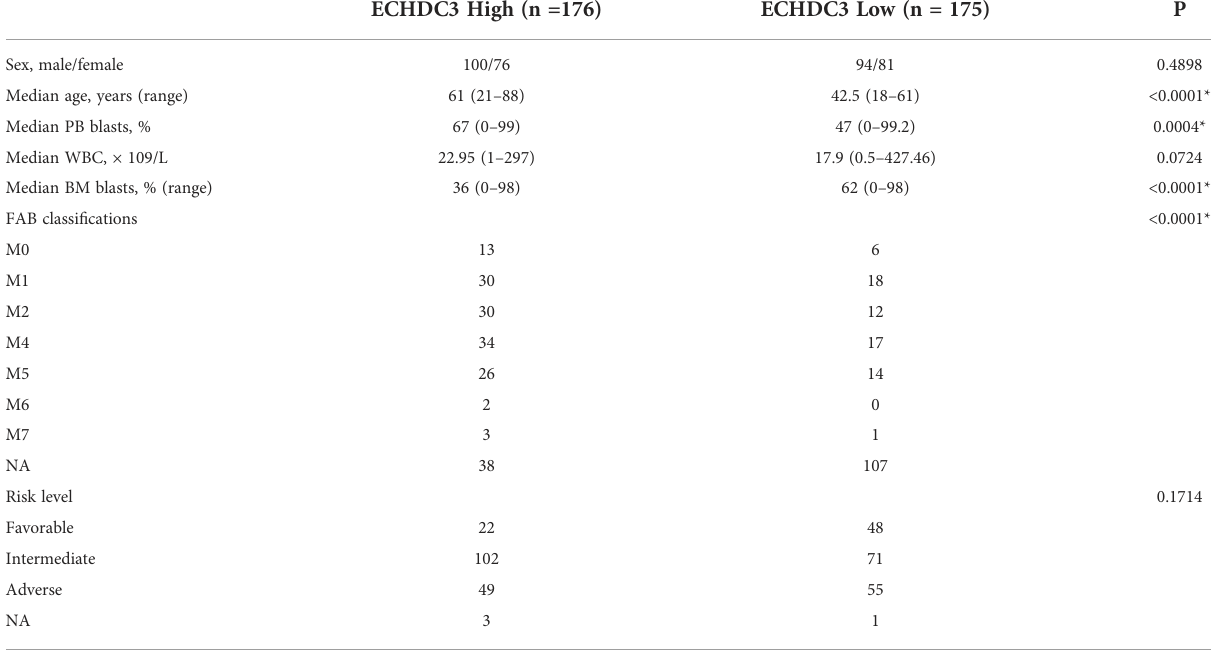
TABLE 1 Patient characteristics of validation